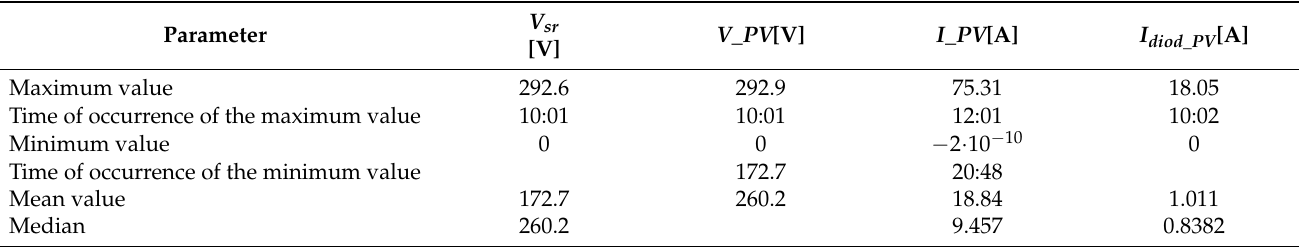
Table 3. Values of voltage and current on PV modules (19.825 kW) and PV diode current on a sample day in